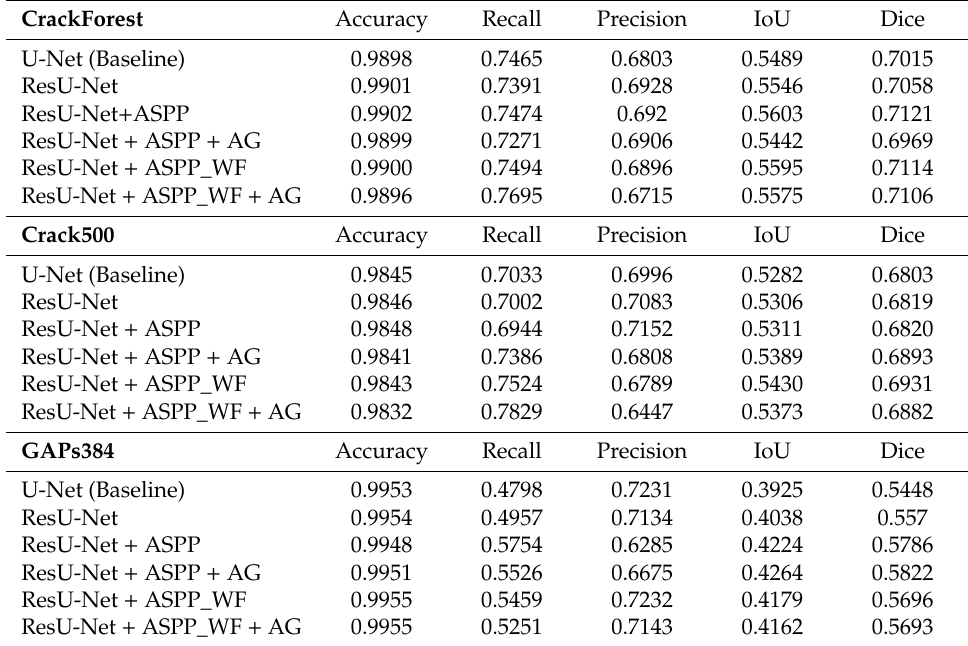
Table 2. Each model’s best weight-prediction results on individual